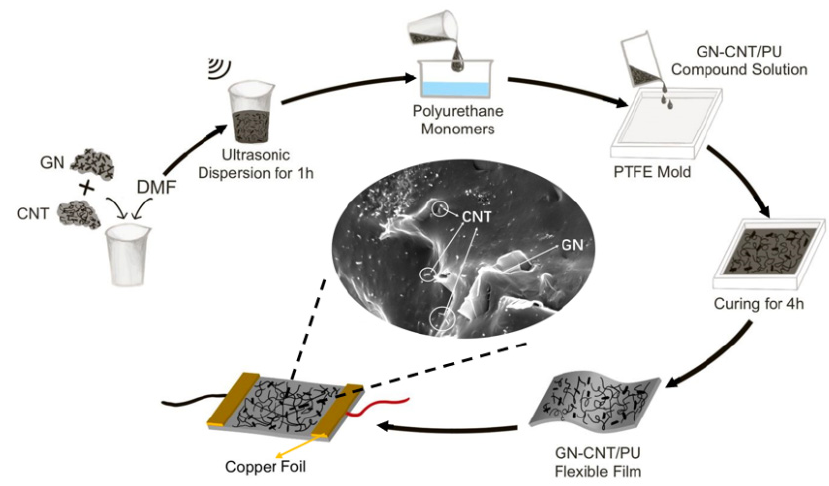
Figure 1. Schematic diagram of preparing GN-CNT/PU film strain sensors.